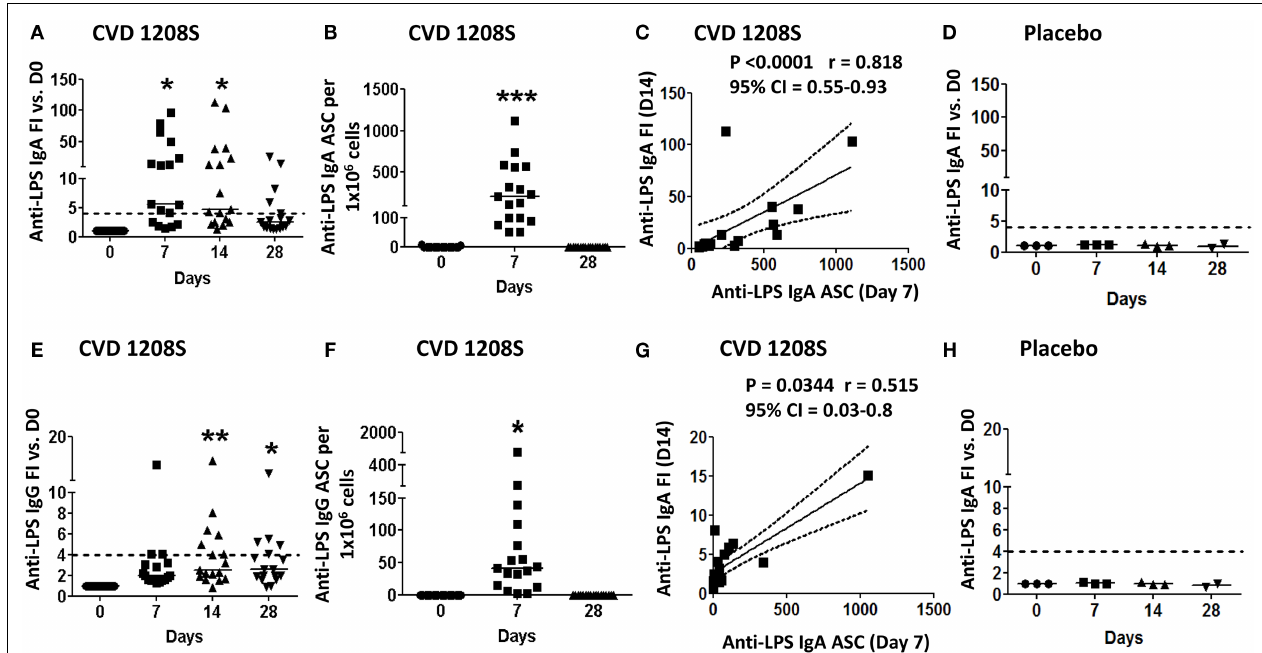
(fold-increase at day 14) and ASC (day 7). (D,H) Sera anti-LPS IgA and IgG in placebo volunteers ( n = 3). In all plots each symbol indicates an individual volunteer. Dotted lines indicate seroconversion (fourfold-increase over day 0). Horizontal bars represent the median in all graphs. Asterisks show statistical significance when compared to day 0 (* p < 0.05; ** p < 0.005; *** p <